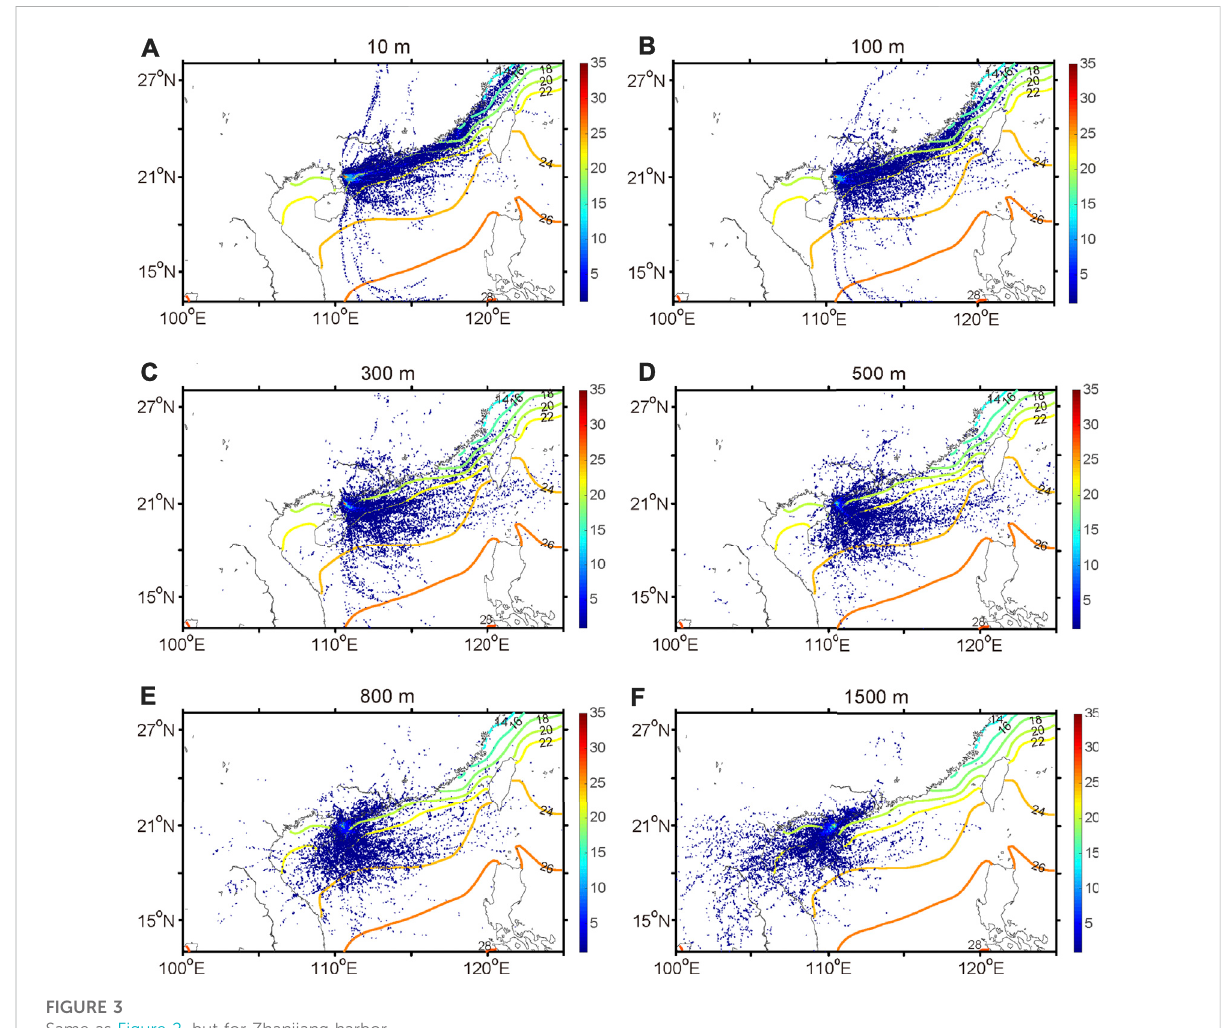
FIGURE 3 Same as Figure 2, but for Zhanjiang